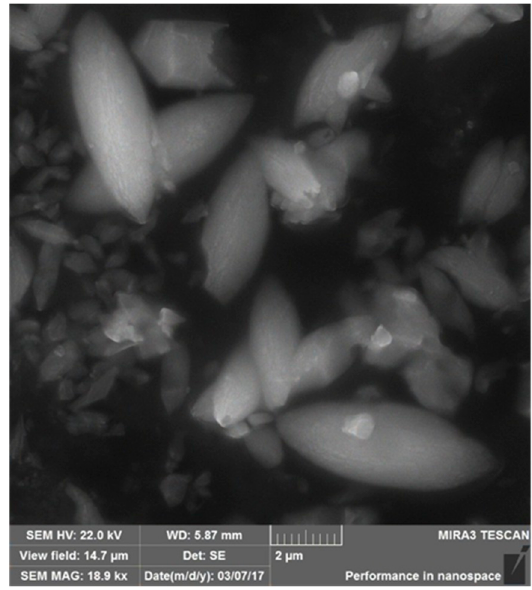
Figure 7. Micrograph of calcined sample SiAl25.